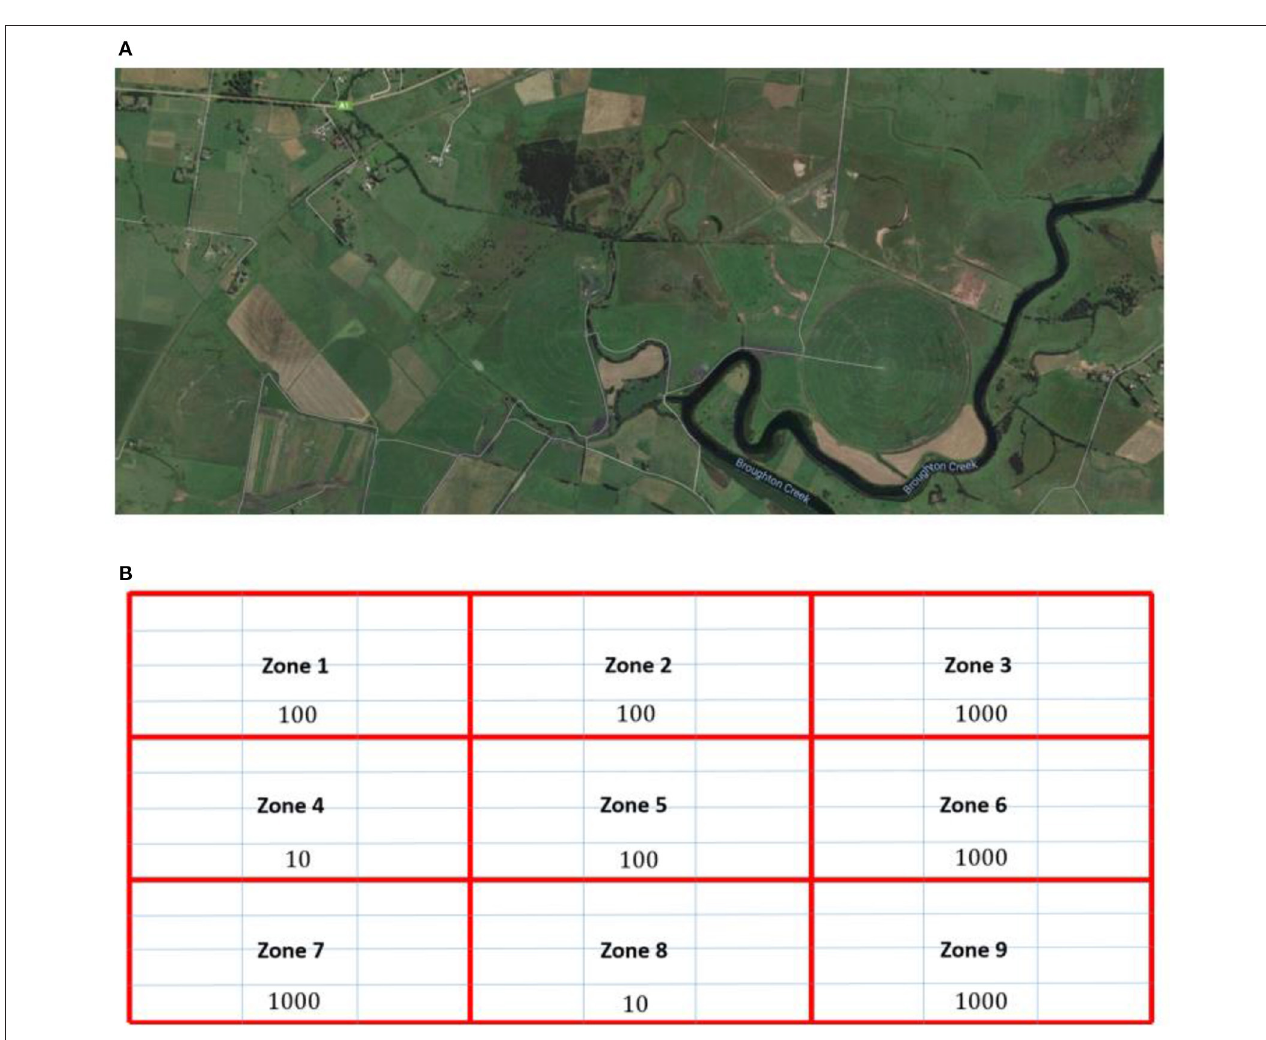
FIGURE 5 | (A) Case example considered; and (B) The distribution of zones and the gird cell discretization for the case study examined. Number in each zone indicate the relative importance of lighting in the zone, with 10 being the least important and 1,000 being the most important.